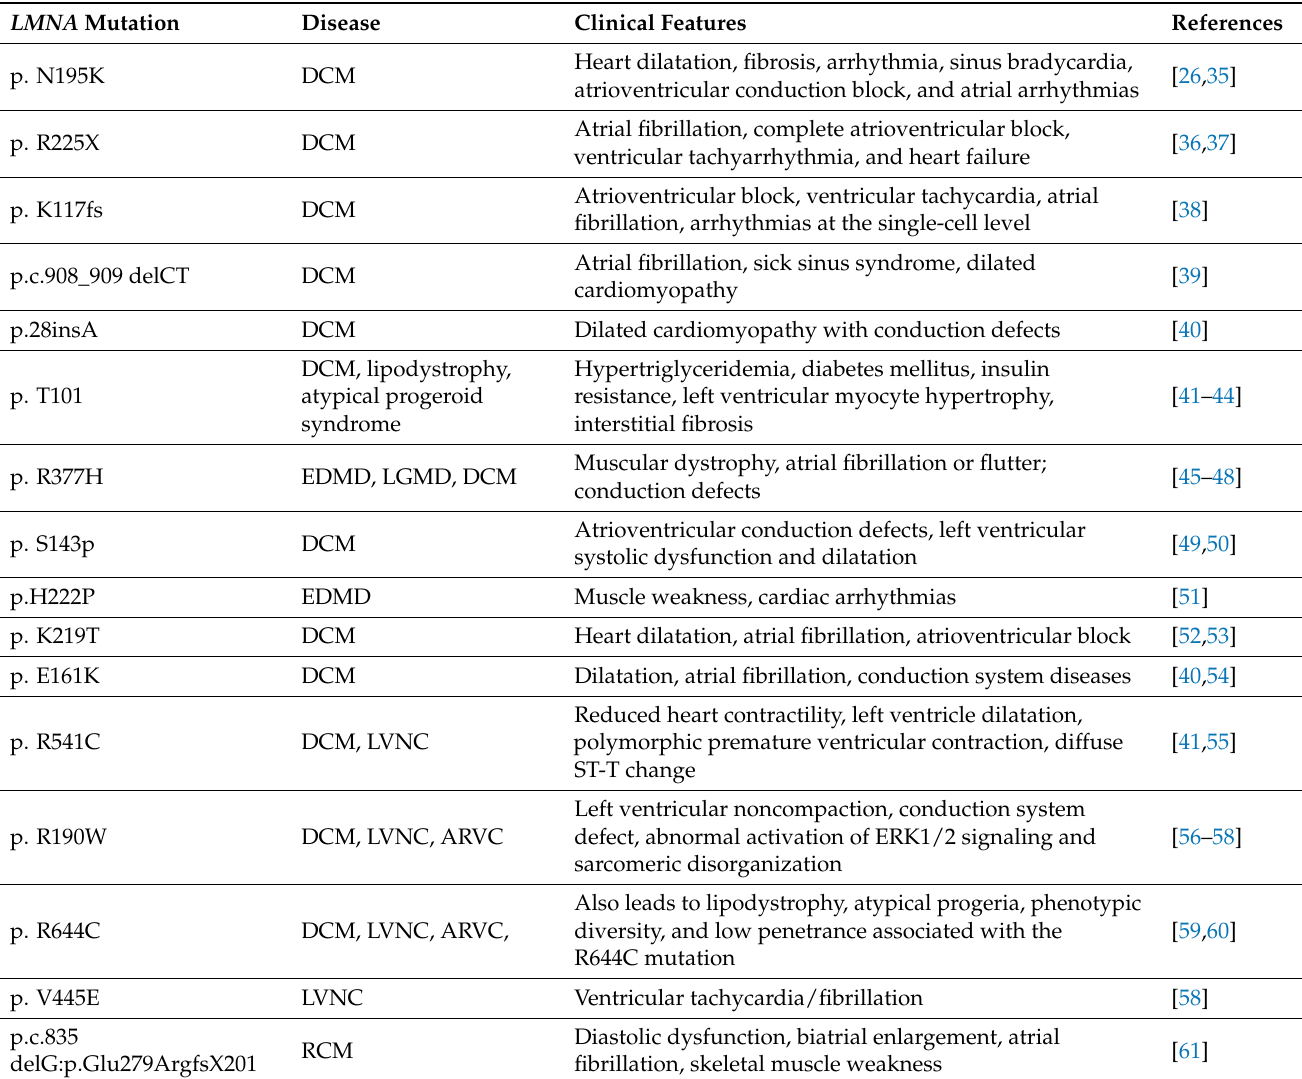
Table 1. Cardiomyopathies caused by the most well studied pathogenic LMNA mutations in patients. Dilated cardiomyopathy (DCM); left ventricular noncompaction cardiomyopathy (LVNC); arrhythmo- genic right ventricular cardiomyopathy (ARVC); restrictive cardiomyopathy (RCM);